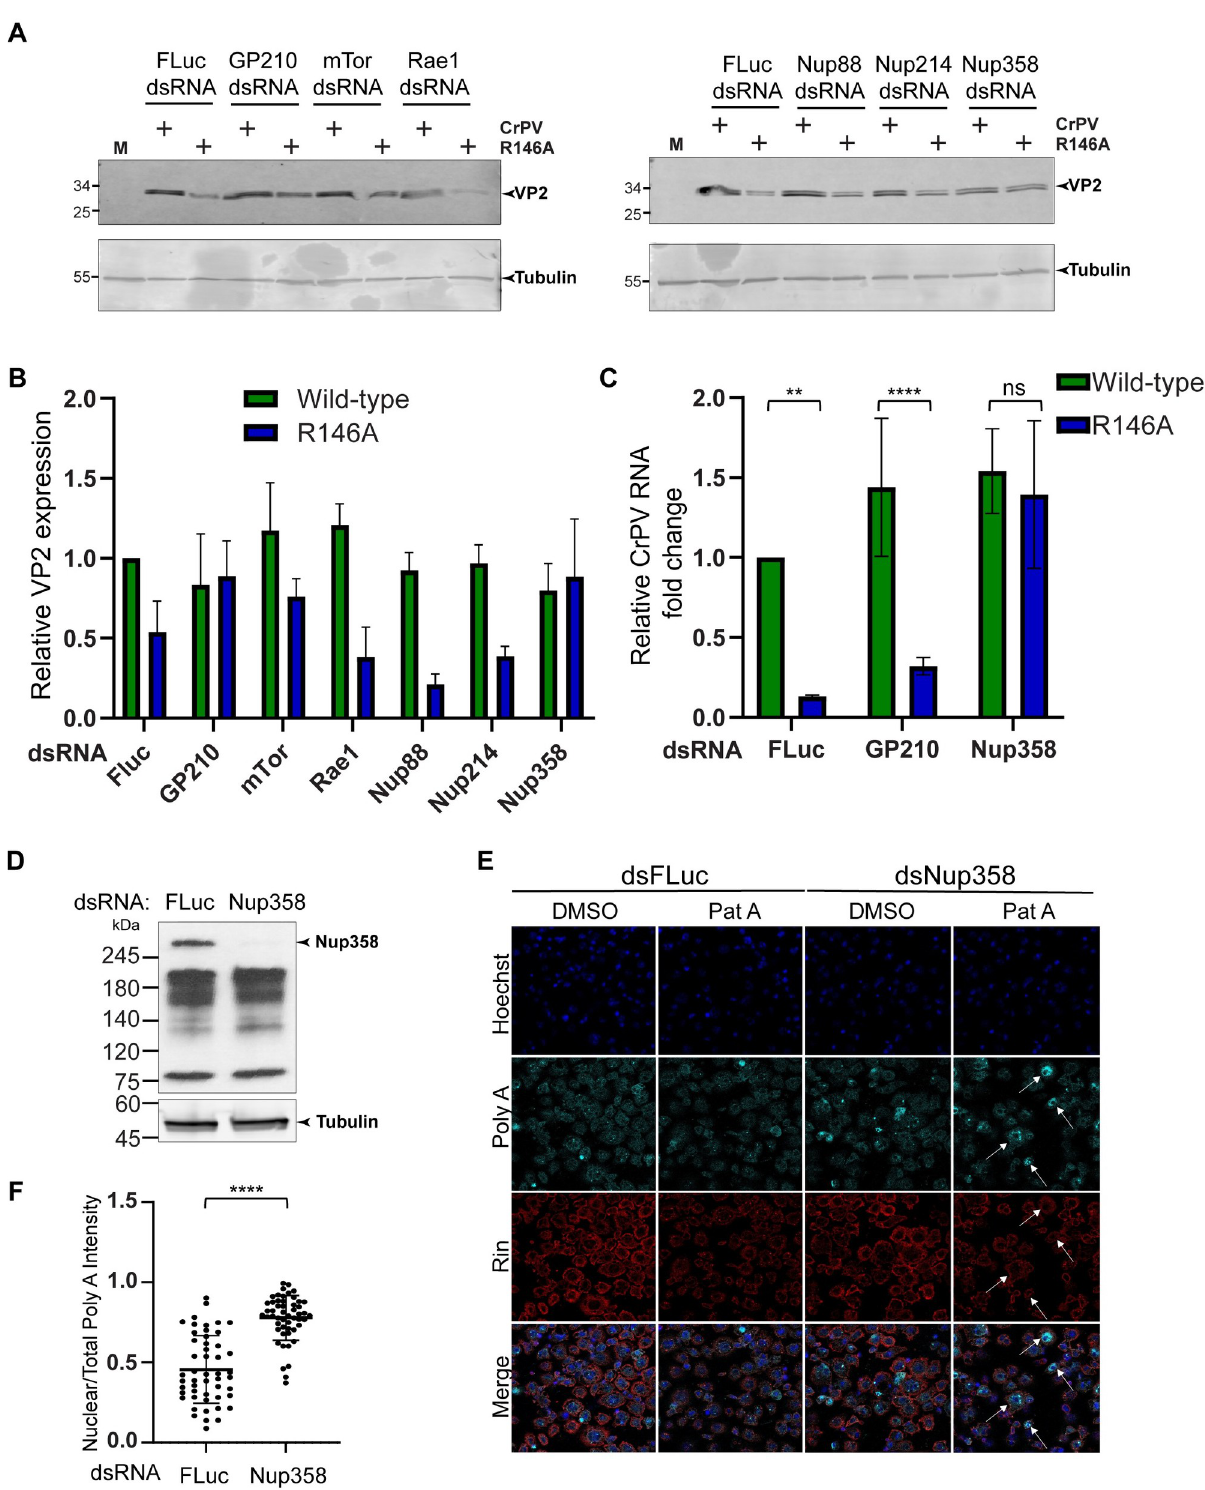
Fig 8. Nup358 promotes CrPV infection in an R146-dependent manner. (A) Immunoblots of S2 cells treated with dsRNA targeting GP210, mTor, Rae1, Nup88, Nup214, Nup358 or control FLuc, followed by mock infection or infection with wild-type or mutant CrPV virus for 8 hours (MOI 1). (B) Quantification of VP2 intensity normalized to tubulin from three independent experiments. The intensity values are normalized to the VP2/Tubulin intensity in FLuc control knockdown cells. (C) CrPV viral RNA levels by qRT-PCR analysis normalized to Rps9 mRNA levels. Data are mean ± SD